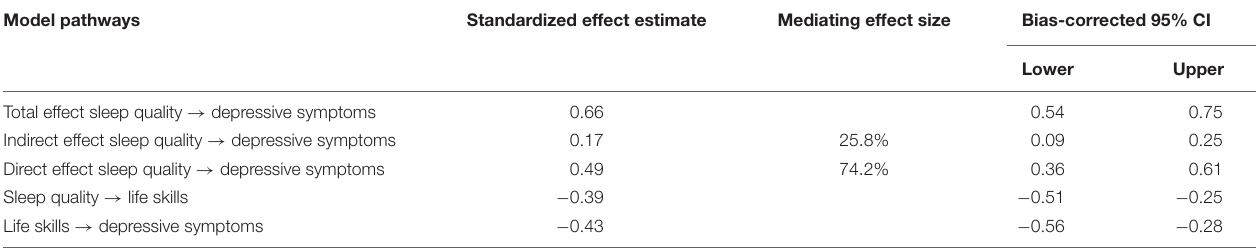
FIGURE 2 | Structural model of life skills as mediator of sleep quality and depressive symptoms. SQ, Pittsburgh Sleep Quality Index; CES-D, Center for epidemiological studies depression scale. TABLE 3 | The total, indirect, and direct effects of sleep quality on depressive symptoms with life skills as a mediator. Model pathways Standardized effect